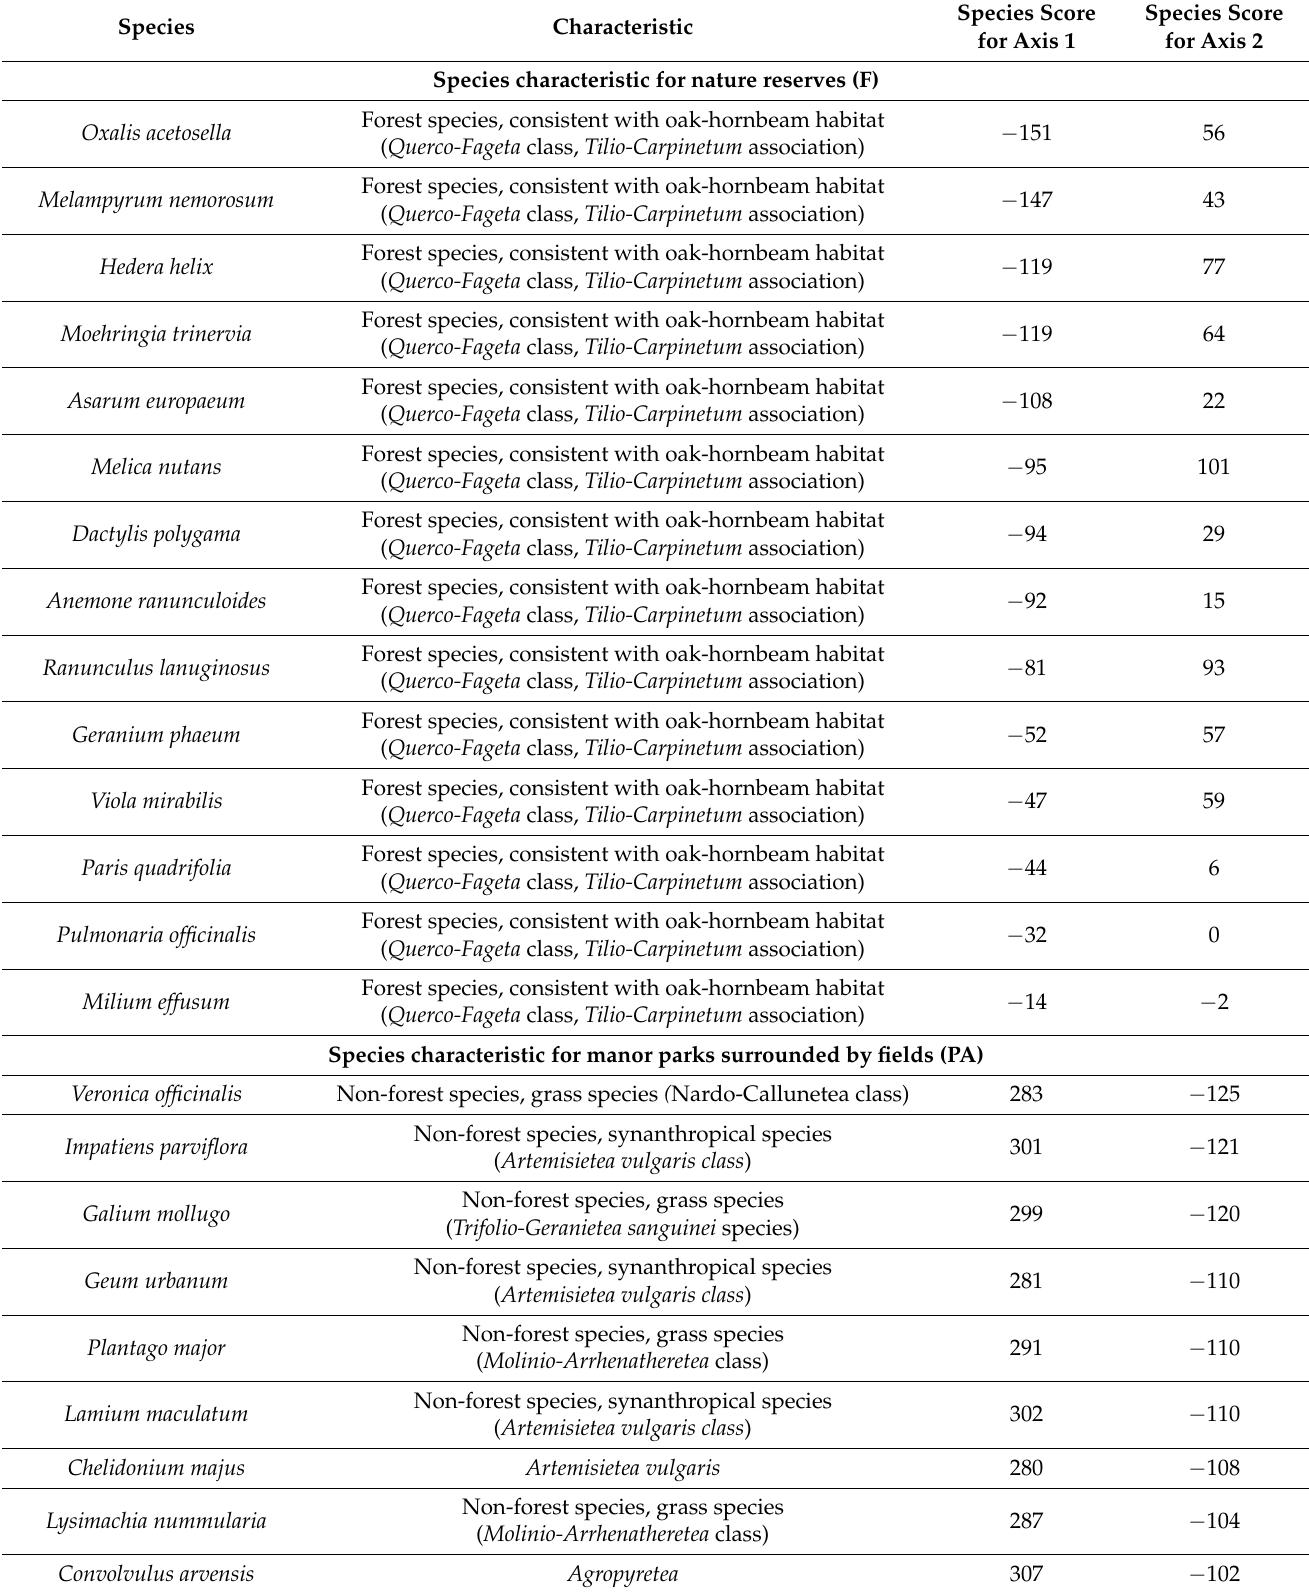
Table 1. Characteristic species for the types of studied objects, their ecological characteristics, and species scores for first and second ordination